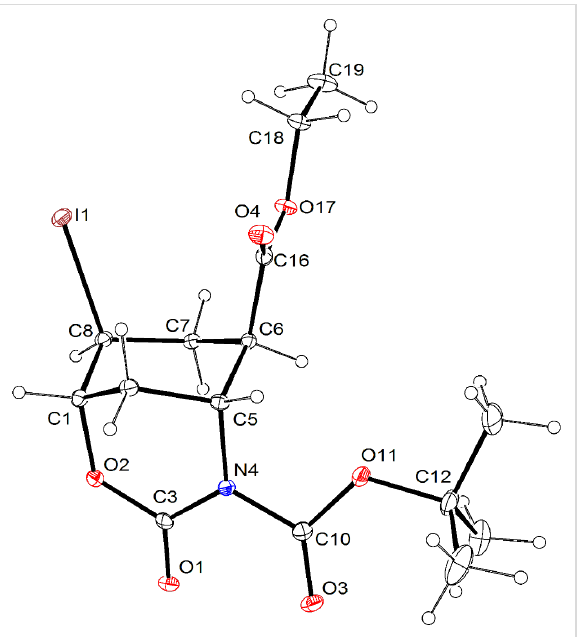
Figure 3: ORTEP diagram of iodooxazinone derivative 12 . Thermal ellipsoids have been drawn at the 20% probability level.